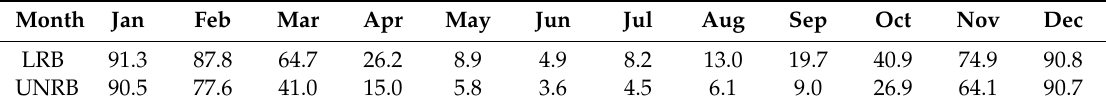
Table 7. Percentage of base flow in total runo ff in the two